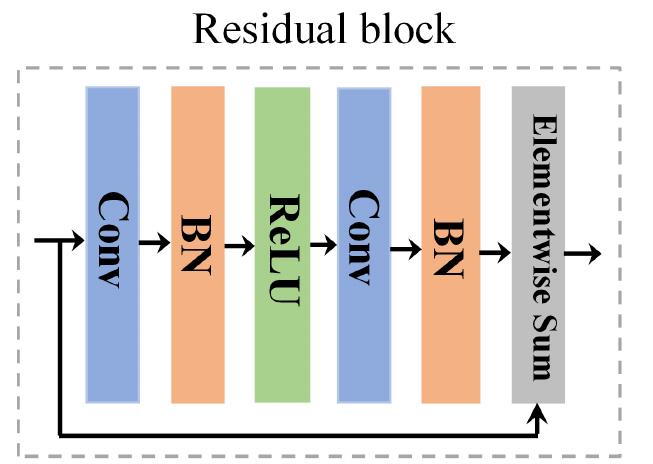
Figure 3. Architecture of the residual block.